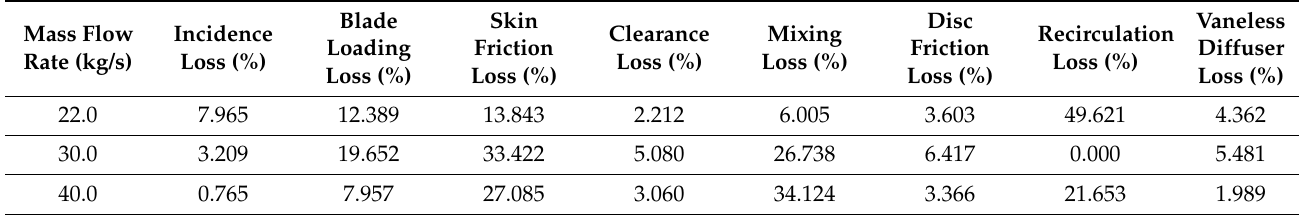
Table 3. Contributions of different losses for the LSCC